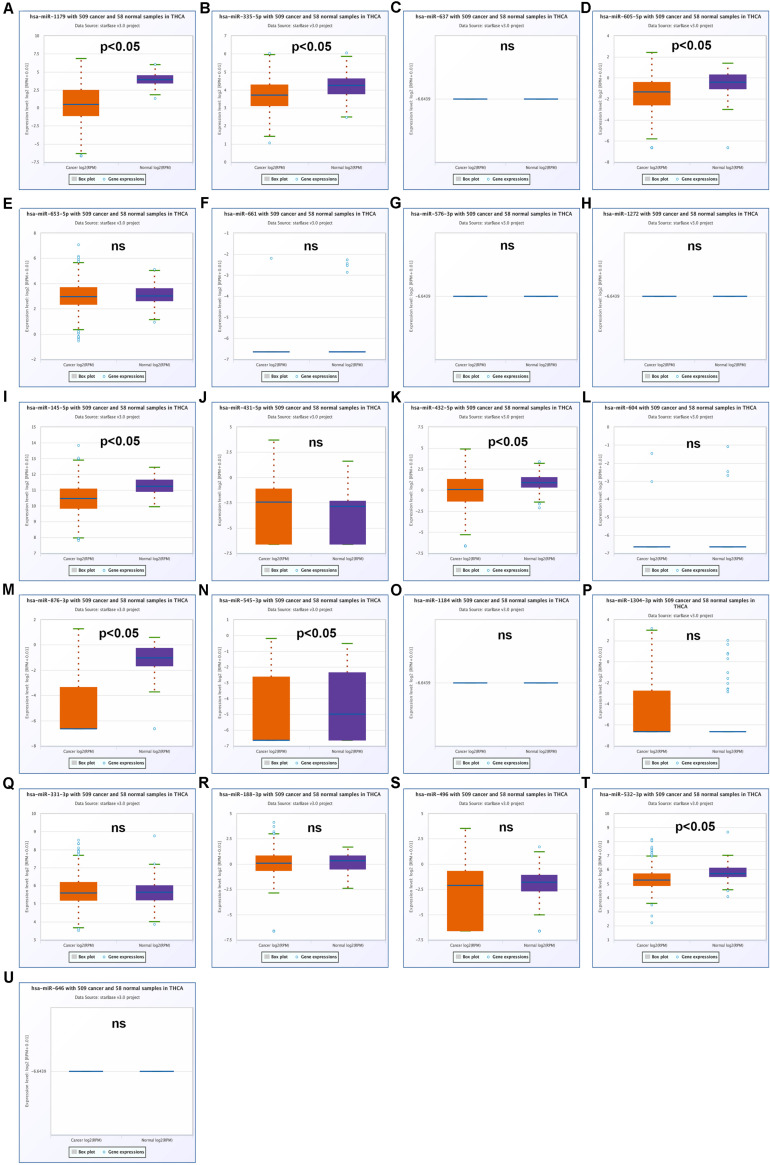
The expression levels of 21 predicted miRNAs that potentially bind to 9 candidate circRNAs in thyroid carcinoma. (A) The expression of miR-1179 in thyroid carcinoma. (B) The expression of miR-335-5p in thyroid carcinoma. (C) The expression of miR-637 in thyroid carcinoma. (D) The expression of miR-605-5p in thyroid carcinoma. (E) The expression of miR-653-5p in thyroid carcinoma. (F) The expression of miR-661 in thyroid carcinoma. (G) The expression of miR-576-3p in thyroid carcinoma. (H) The expression of miR-1272 in thyroid carcinoma. (I) The expression of miR-145-5p in thyroid carcinoma. (J) The expression of miR-431-5p in thyroid carcinoma. (K) The expression of miR-432-5p in thyroid carcinoma. (L) The expression of miR-604 in thyroid carcinoma. (M) The expression of miR-876-3p in thyroid carcinoma. (N) The expression of miR-545-3p in thyroid carcinoma. (O) The expression of miR-1184 in thyroid carcinoma. (P) The expression of miR-1304-3p in thyroid carcinoma. (Q) The expression of miR-331-3p in thyroid carcinoma. (R) The expression of miR-188-3p in thyroid carcinoma. (S) The expression of miR-496 in thyroid carcinoma. (T) The expression of miR-532-3p in thyroid carcinoma. (U) The expression of miR-646 in thyroid carcinoma. “p < 0.05” represents significant difference, and “ns” represents no significance.